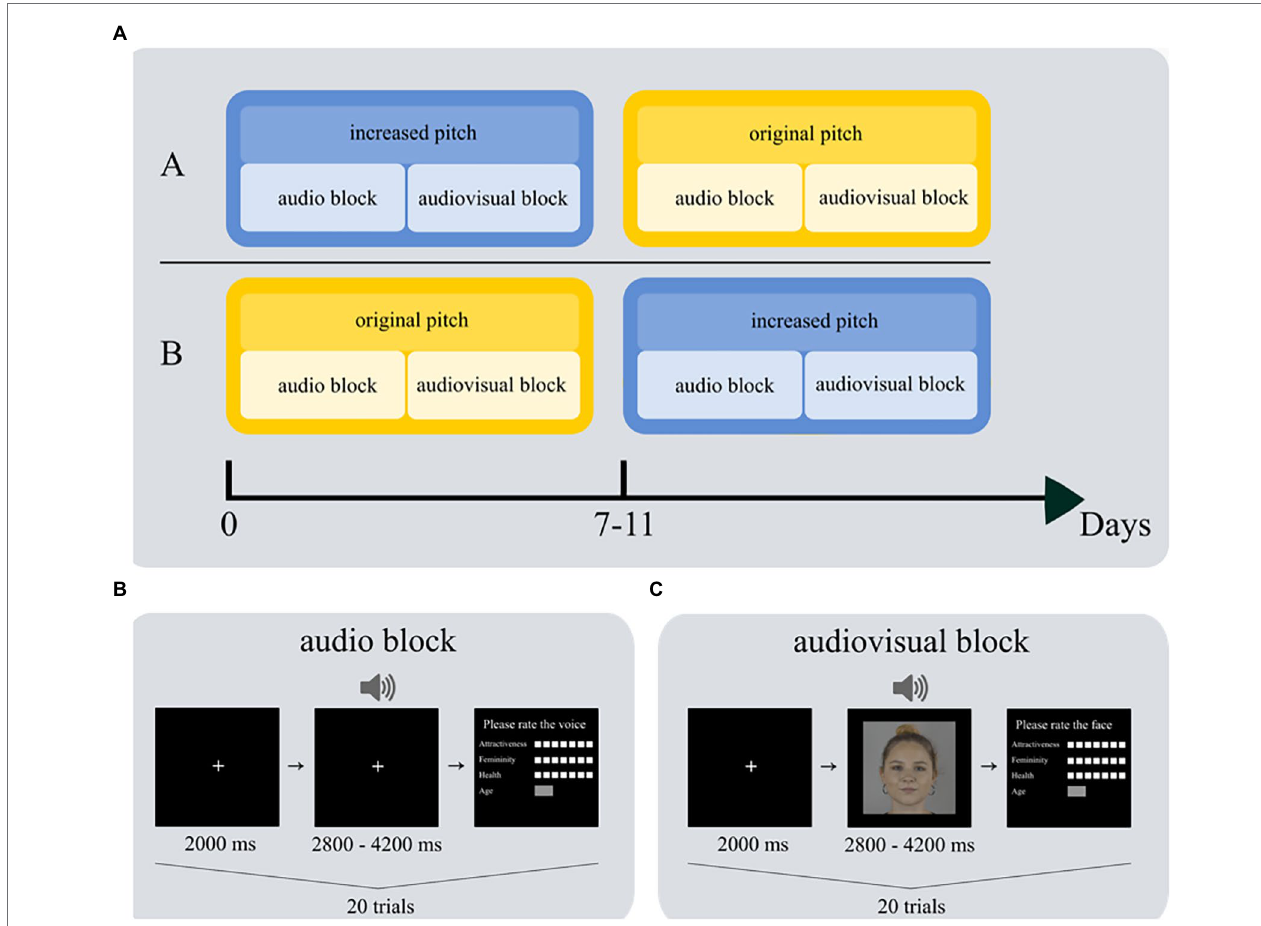
FIGURE 1 | Experimental set-up. (A) Participants were randomly assigned to order A or B. They completed two sessions with 7–11 days in between. On each session, they first completed the audio block and then the audiovisual block; sessions differed regarding voice pitch. Each participant completed 20 trials in the audio block (B) and 20 trials in the audiovisual block (C) . The depicted face is for example purposes only; although it is not contained in the database, it was recorded under the same